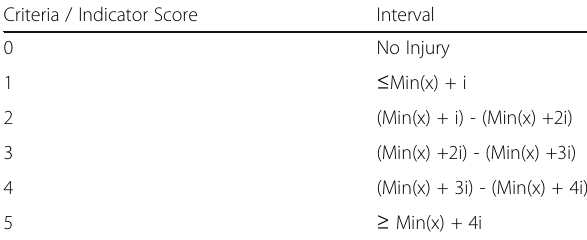
Table 7 Interpretation criteria and indicator score Criteria / Indicator Score